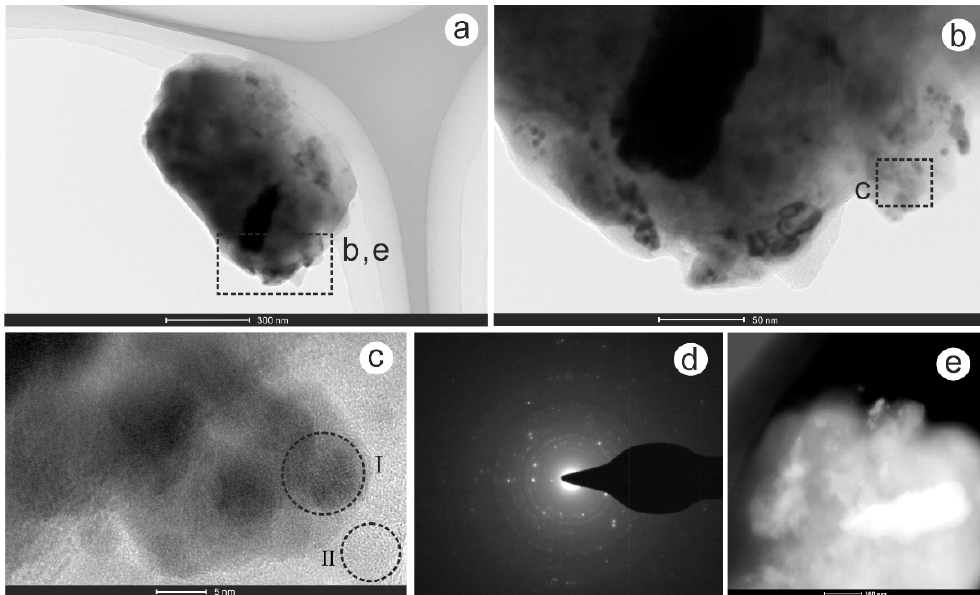
Figure 3. A gold-bearing nanoparticle in soil sample over the studied gold deposit; ( a ) TEM image; ( b ) TEM image; ( c ) high-resolution transmission electron microscope (HRTEM) image; ( d ) selected area electron diffraction (SAED) pattern; ( e ) scanning transmission electron microscope with high angle annular dark field (STEM-HAADF) image. Note that some small nanoparticles adsorb on the surface of a big particle.